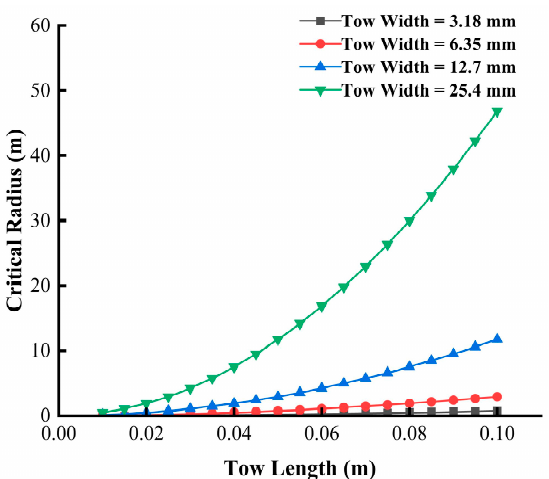
Figure 11. Critical steering radius of the tow plotted against length.